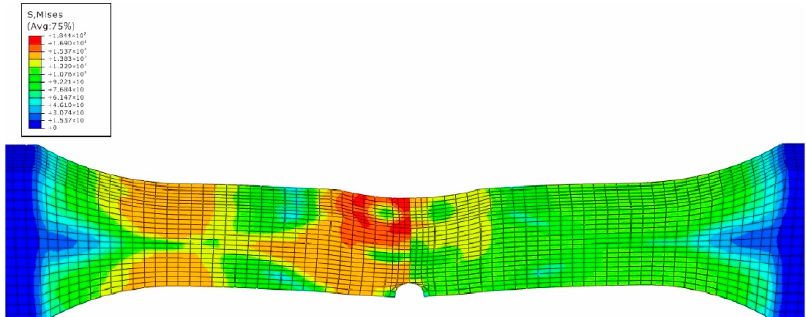
Figure 7. Stress field of impacted surface of dissimilar lightweight materials welded joint.